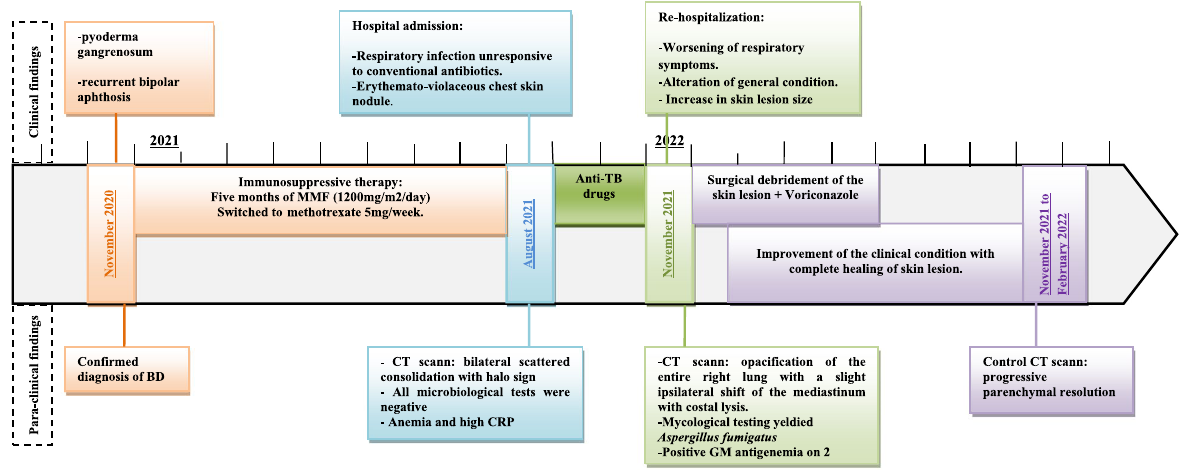
Fig. 6 Case report timeline, made in accordance with CARE